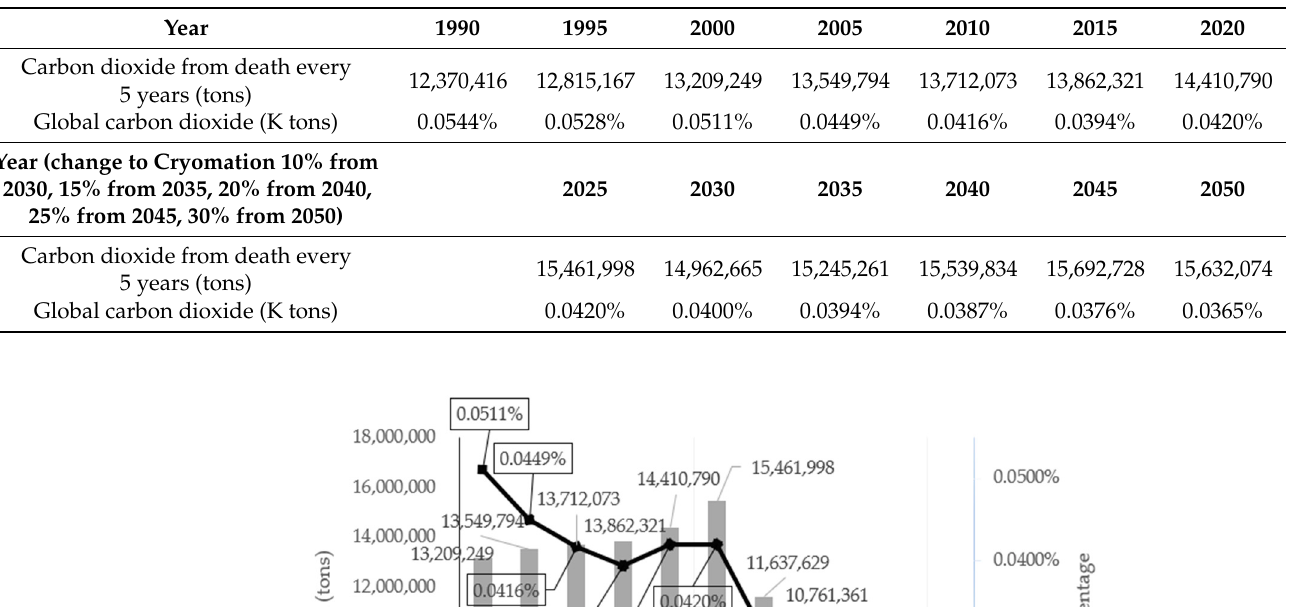
Table 4. The simulation of carbon dioxide generated from the death toll from 10% to 30% every 5 years between 2030 and 2050.